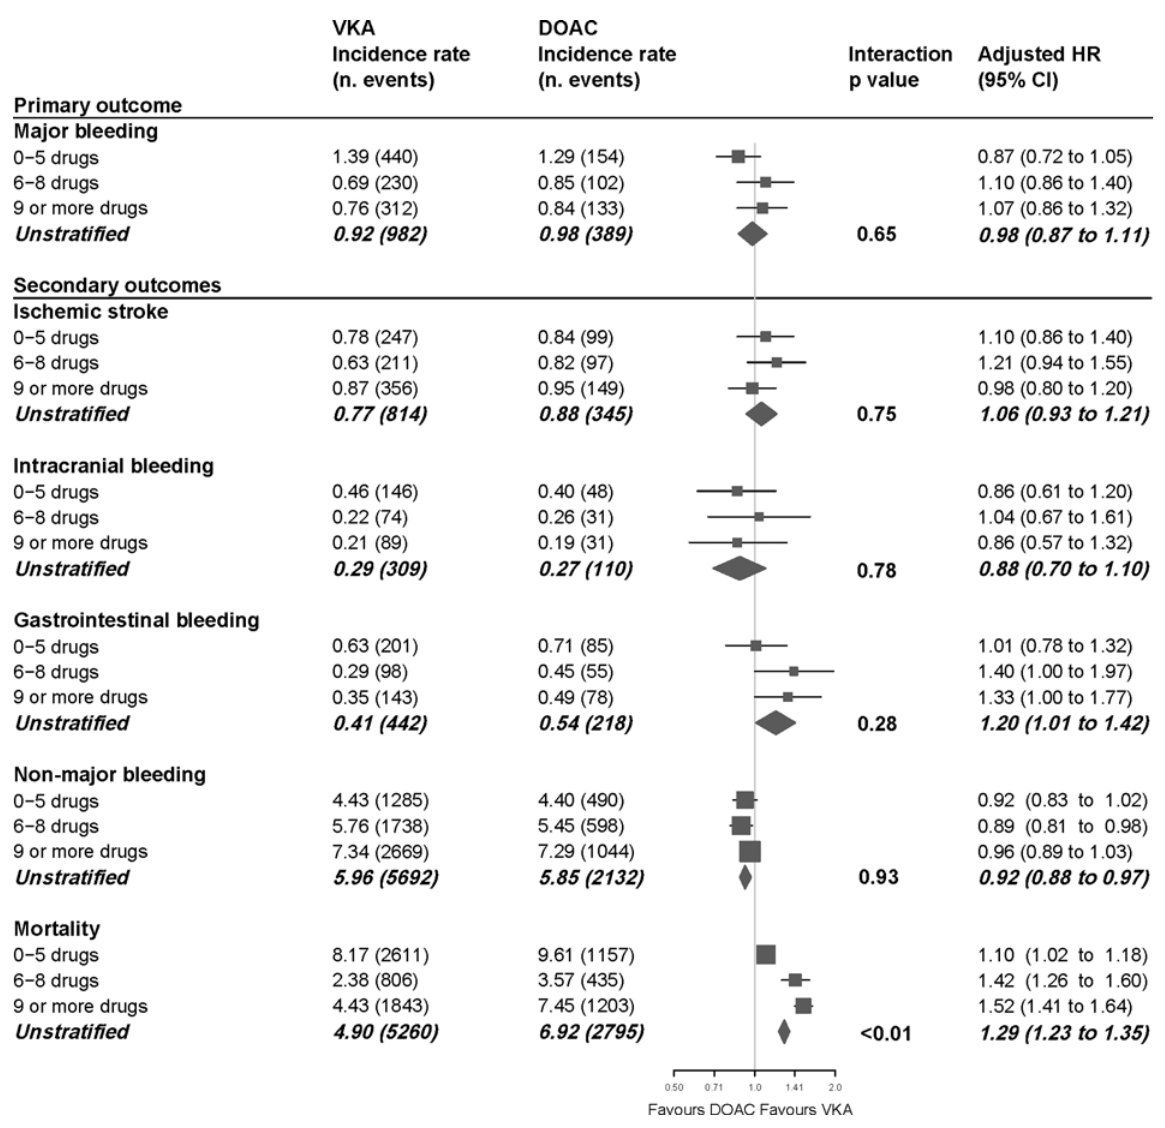
Fig. 3 Incidence rates per 100 person-years, interaction p -values and adjusted hazard ratios with 95% con fi dence intervals for primary and secondary